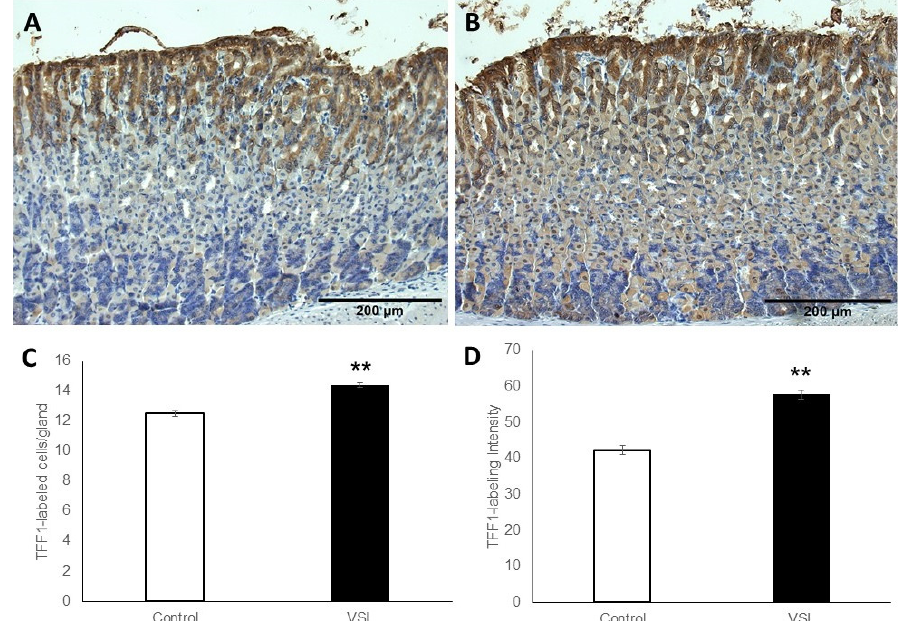
Figure 3. Immunohistochemical analysis of TFF1 in gastric mucosal tissue sections obtained from control and VSL-treated mice. Note that TFF1-labeled epithelial cells (brown cytoplasm) of VSL-treated tissues in ( B ) appear more expanded at the pit region of gastric gland when compared with control tissues in ( A ). Magnification, 20×, scale bar: 200 µm. Analysis of TFF1-labeled cell counts per gland in the gastric corpus of control and VSL-treated mice ( C ), and TFF1-labeling intensity per field in the oxyntic glands of control and VSL treated mice ( D ). Data from four control and four VSL-mice are presented as mean ± SE. The asterisk indicates significant differences from the control group. ** p < 0.01.